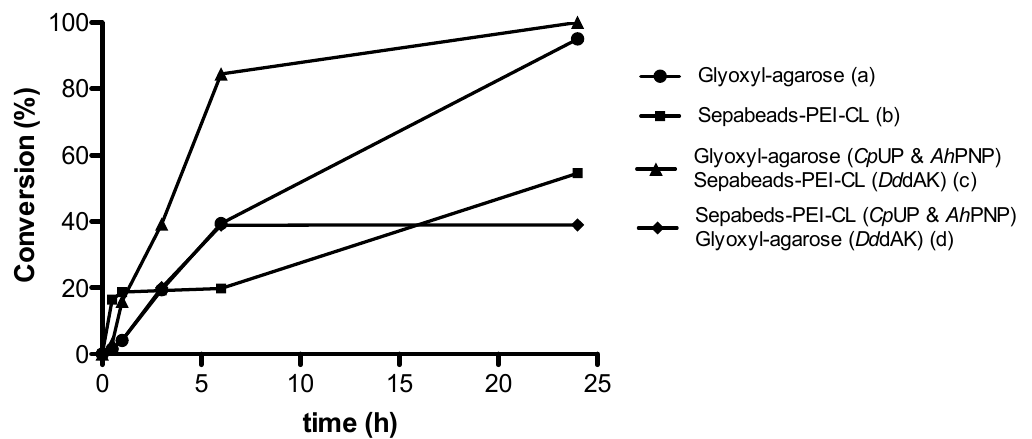
Figure 1. Time course of araA-MP synthesis catalyzed by Cp UP, Ah PNP, and Dd dAK immobilized according to Table 1. Experimental conditions as reported in Table 1 (reaction assay conditions).